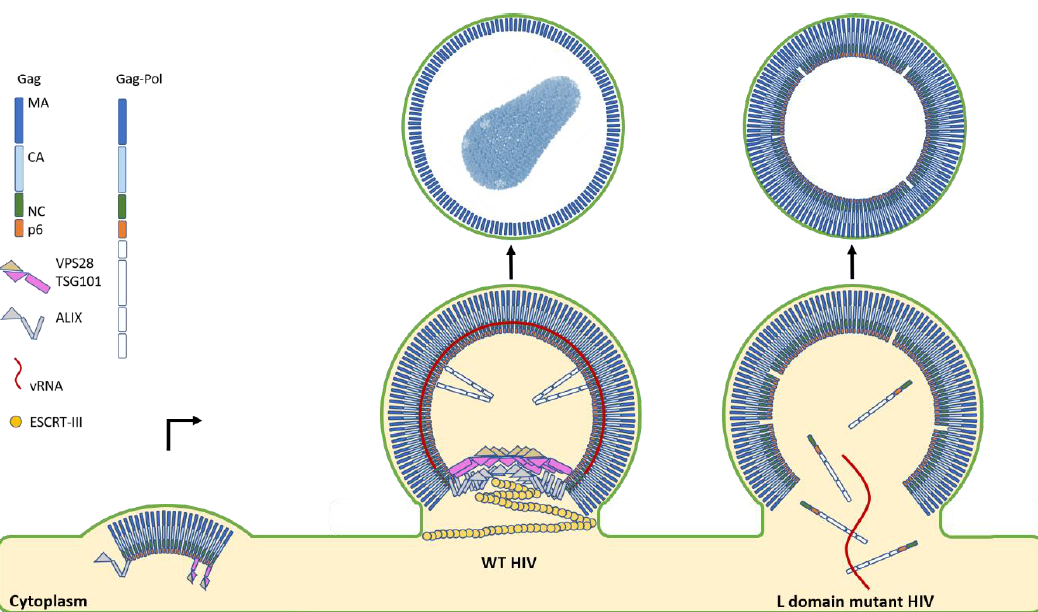
Figure 2. HIV budding diagram depicts the role of the upstream ESCRTs in virion maturation and release. The first step in HIV budding is the clustering of lower-order Gag multimers at the membrane. This occurs with a concomitant recruitment of the ESCRT-I component TSG101 and ALIX to sites of assembly when both L domains are intact. In the case of mutant HIV where one or both L domains are deleted, severe temporal delays in budding are observed. Additionally, particles are found with immature Gag shells, indicative of processing defects due to the leakage of the processing enzymes within the Gag-Pol polyprotein back into the cytoplasm. In stark contrast to this severe budding phenotype, when both L domains are present, ESCRT-I and ALIX are recruited to sites of assembly and remain there during the late stages of maturation. The presence of ESCRT-I and ALIX also coincides with an optimal efficiency of processing by the retroviral protease due to its retention and proper activation within maturing virions. ALIX then recruits the downstream ESCRT-III CHMP4B for the sealing and scission of the budding virion to allow for the rapid and efficient release of progeny virions.